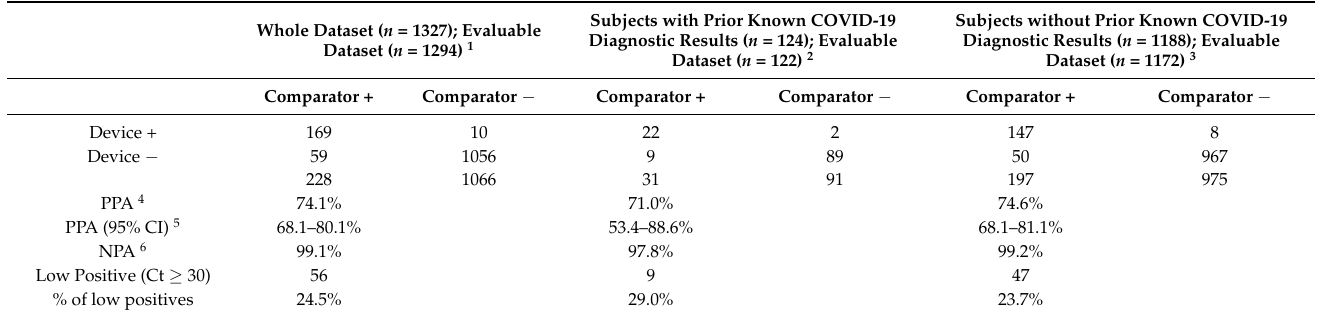
Table 4. Clinical performance of the